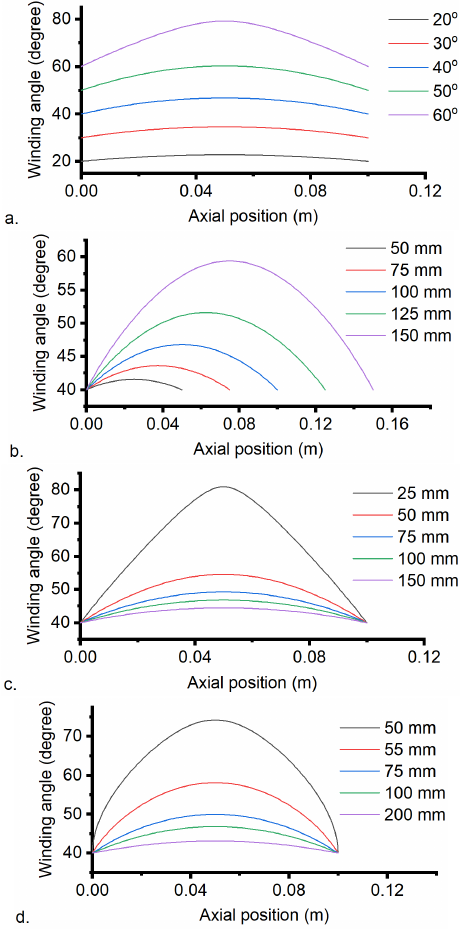
Figure 5: Distribution of winding angle at different H . The initial structure vector H 0 = [0.1, 0.1, 0.1, 40] : (a) varied initial winding angles θ 0 ; (b) varied axial lengths L ; (c) varied circumferential radius at the ends r ; (d) varied meridional radius R α .